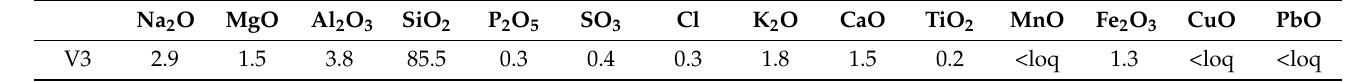
Table 5. SEM/EDX results in wt% for the studied stonepaste body of vessel ( N = 1).